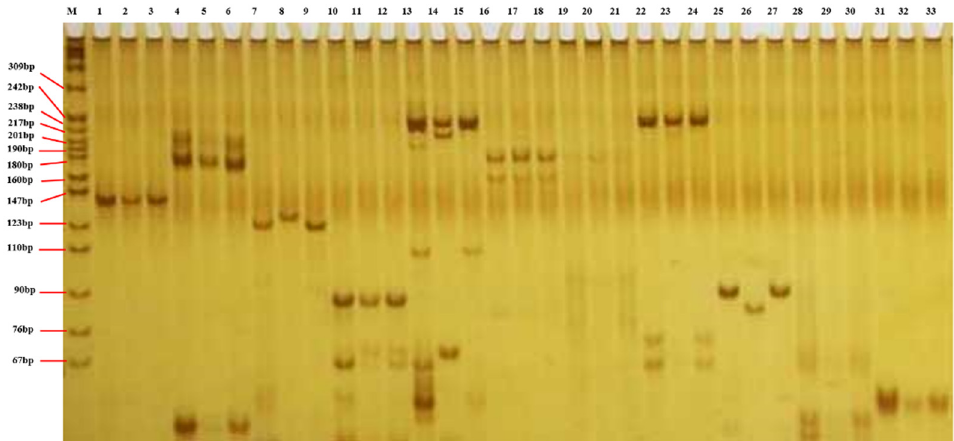
Figure 4. SSR marker screening among parents. Electrophoresis lanes: M is Marker pBR322 DNA/Msp Ⅰ ; the samples are from Huangzao4, Jing7, and Chang7 ‐ 2, respectively; 1, 2, and 3 are bnlg1083; 4, 5, and 6 are bnlg1614; 7, 8, and 9 are bnlg1953; 10, 11, and 12 are umc1169; 13, 14, and 15 are bnlg1458; 16, 17, and 18 are umc1321; 19, 20, and 21 are umc1073; 22, 23, and 24 are umc1114; 25, 26, and 27 are phi078; 28, 29, and 30 are umc1944; 31, 32, and 33 are umc1095.